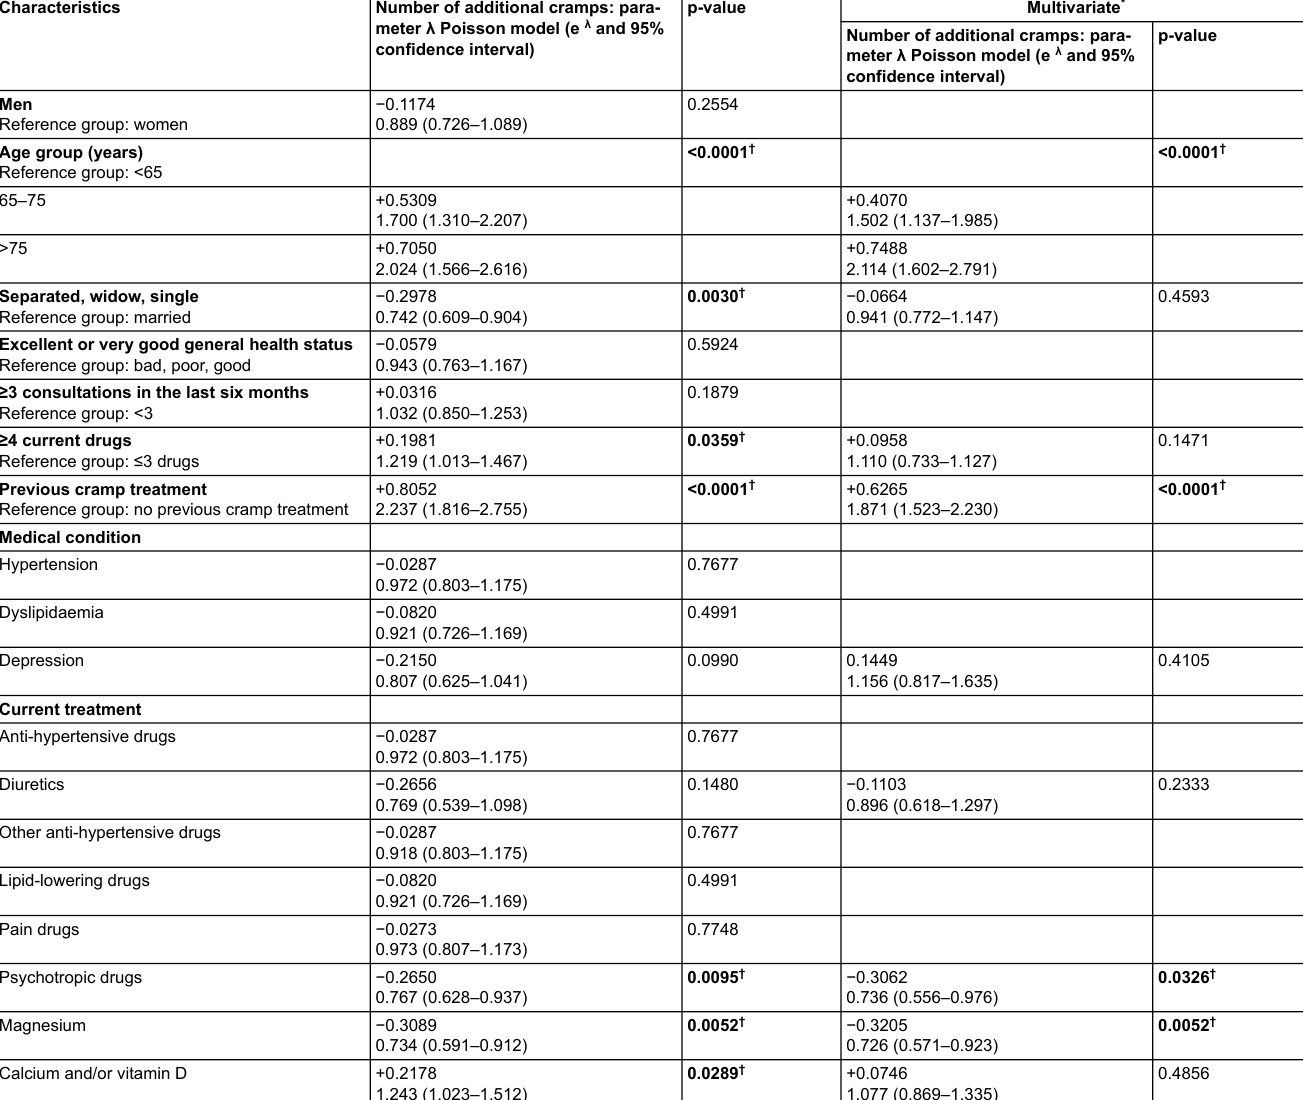
Table 3: Unadjusted and adjusted association between the number of cramps per day and patient characteristics (n = 129).